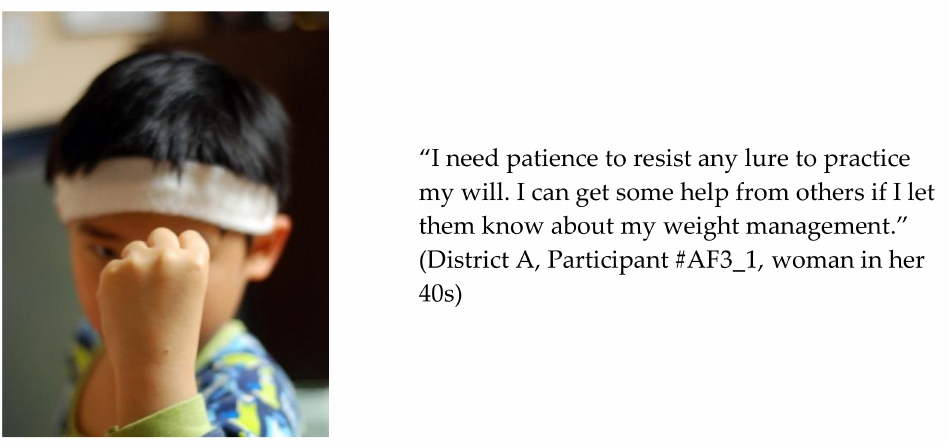
Figure 7. Picture and statement depicting an individual’s desire to practice his/her